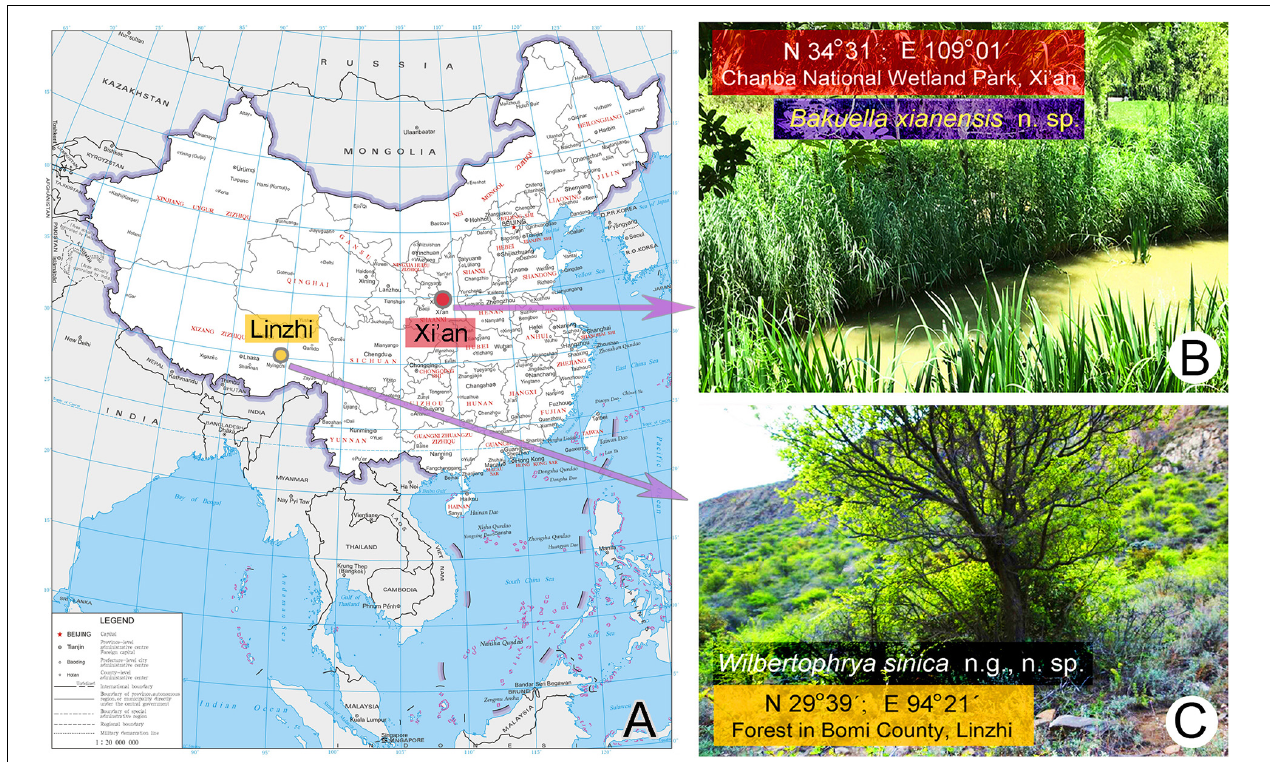
FIGURE 1 | Sample sites. (A) The map of China from the MAP WORLD [www.tianditu.gov.cn, drawing review number: GS (2019) 1708] showing the location of the sampling sites. (B) Wetland at Chanba National Wetland Park, Xi’an, where Bakuella xianensis n. sp. was collected. (C) Forest in Bomi County, Linzhi, Tibet, where Wilbertophrya sinica n. sp. was